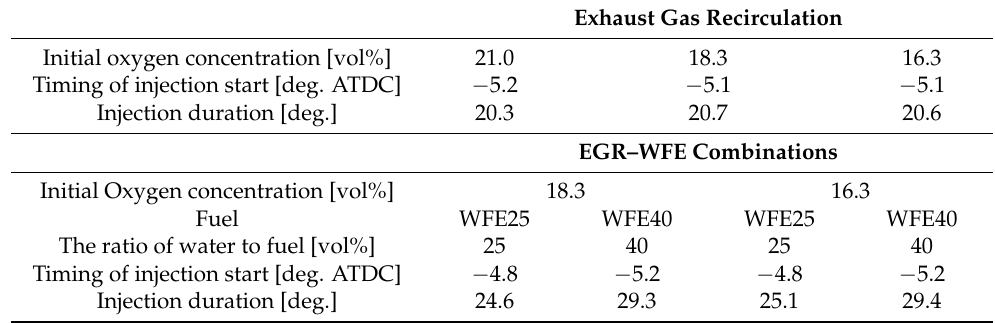
Figure 5. The instantaneous emulsion system before injection.